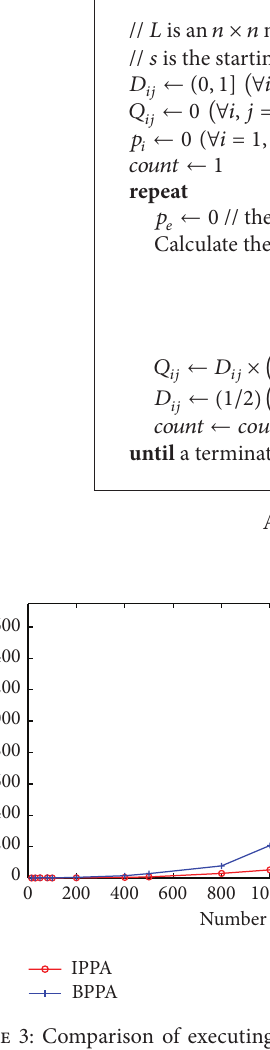
Figure 4: Comparison of running iterations on randomly generated networks. IPPA refers to the improved Physarum polycephalum algorithm while BPPA represents the basic Physarum polycephalum